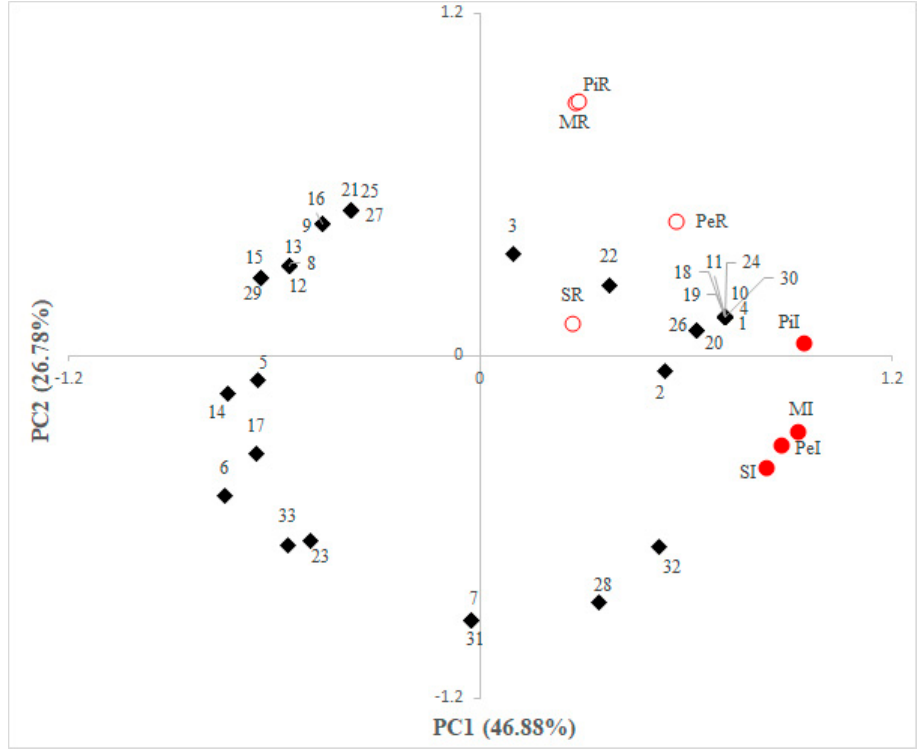
Figure 3. Principal component analysis (PCA) of volatile compounds (lozenges) identified in the different treatments of ripe (open circles) and immature (closed circles) coffee beans. Abbreviations: